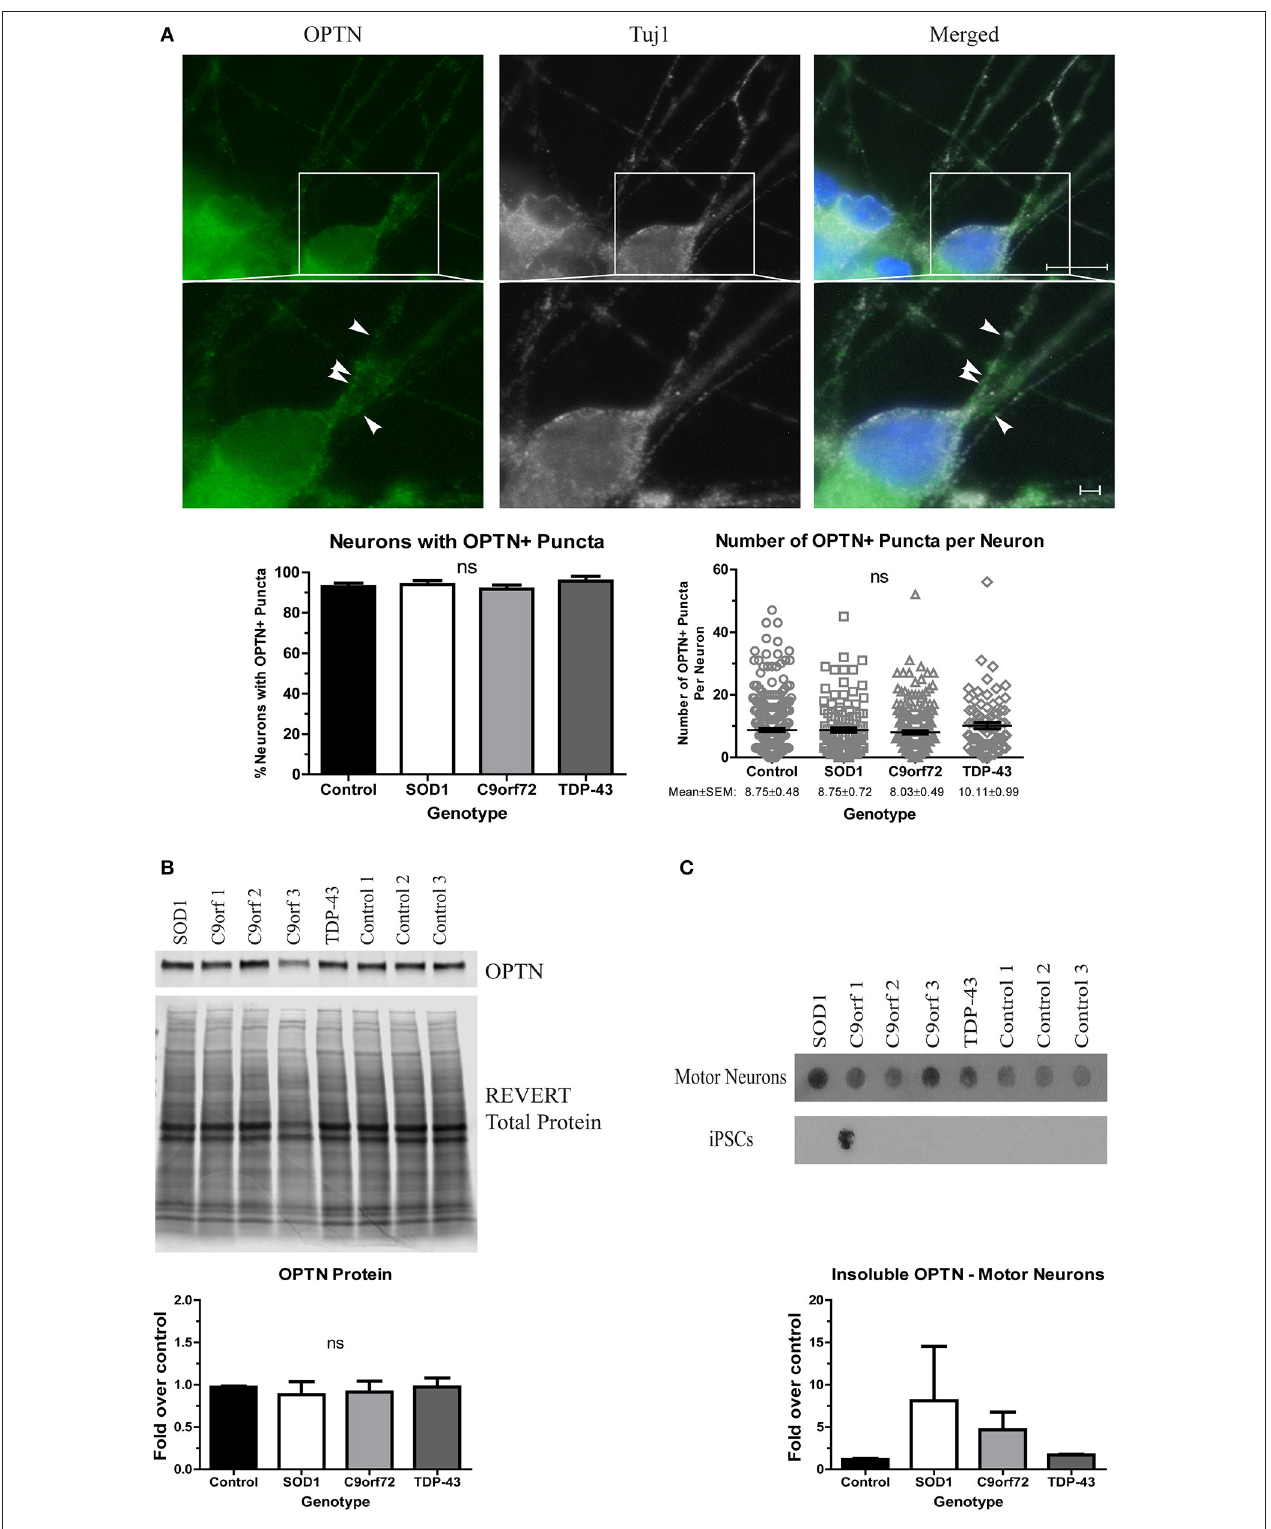
FIGURE 4 | OPTN is insoluble in SOD1 and C9orf72 motor neurons. (A) Representative immunocytochemistry images of Hoechst nuclear stain (blue), OPTN (green), and Tuj1 (white) at 4 weeks of differentiation. No difference is seen in the number of neurons with OPTN + puncta (ns, p > 0.05 by one-way ANOVA with